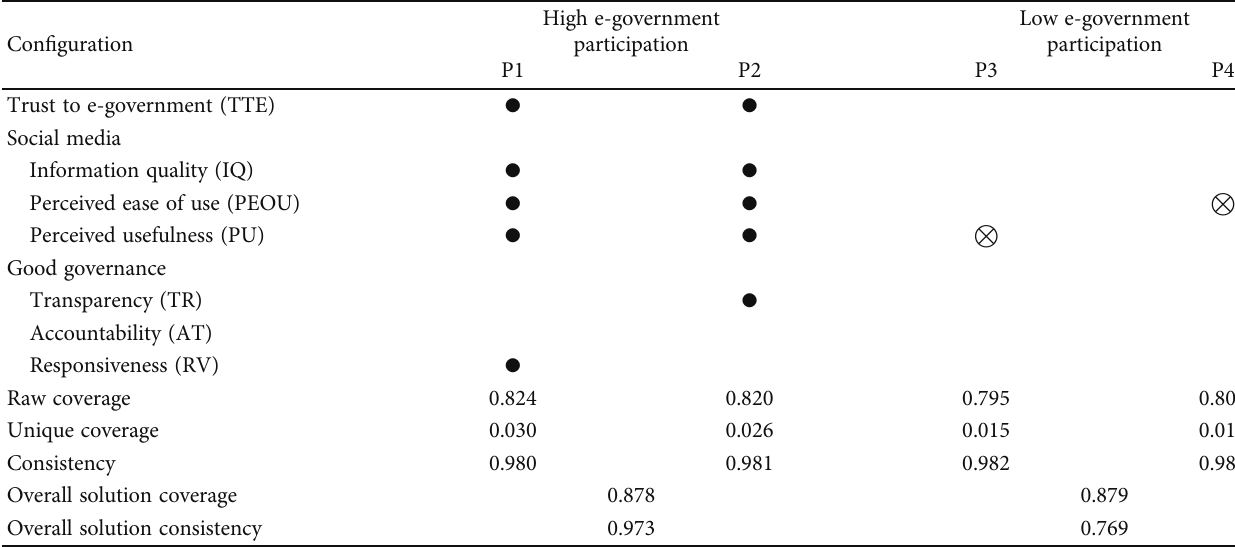
Table 10: Con fi guration for “ high ” and “ low ” e-government